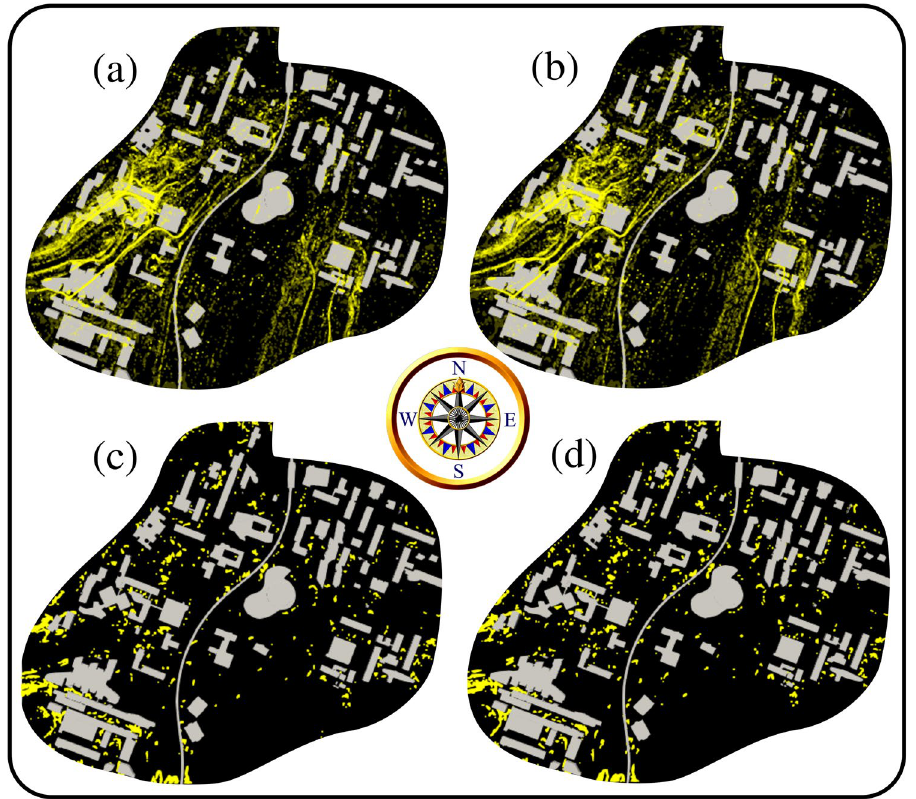
Figure 5. Pollen grain density effect investigated at the weather conditions on 06/04/2020. Computational results at t = 6 min. ( a ) Domain top view with ρ p = 800 kg/m 3 ; ( b ) domain top view with ρ p = 1700 kg/m 3 ; ( c ) pollen grains at the ground level with ρ p = 800 kg/m 3 ; ( d ) pollen grains at the ground level with ρ p = 1700 kg/m 3